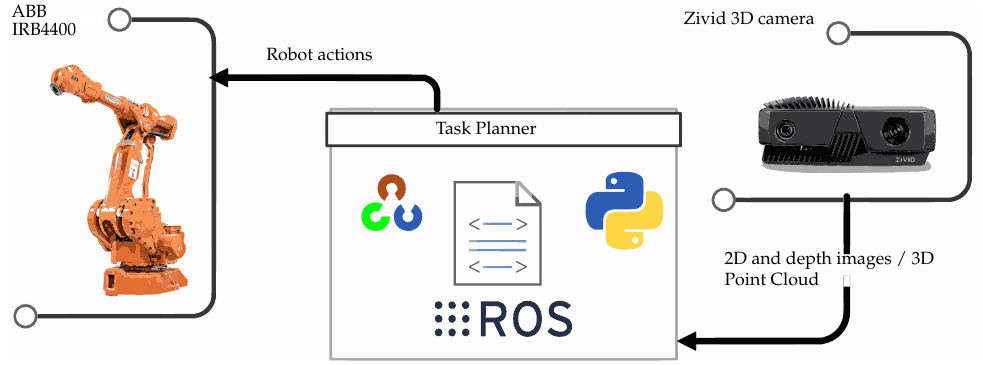
Figure 1. Task planner concept